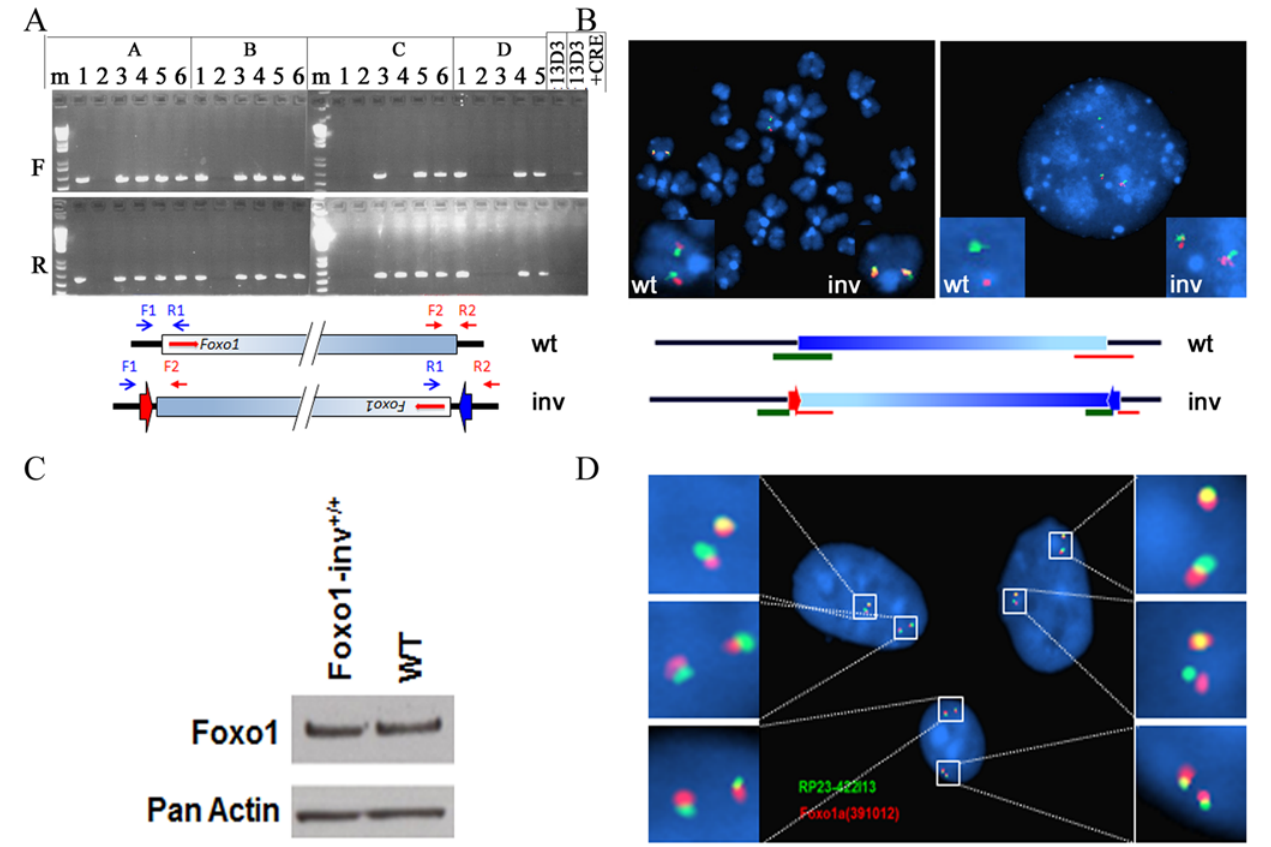
Figure 3. Analyses of inversion of the 4.9Mb syntenic region in double targeted ES cells. A. PCR analyses of CRE-transfected, FIAU selected ES cell clones. F, PCR amplification of the 4.9Mb borders using forward primers (RP24-F1 (blue arrow) and RP23-F2 (red arrow)); R, PCR amplification of the 4.9Mb borders using reverse primers (RP24-R1 (blue arrow) and RP23-R2 (red arrow)). Presence of PCR fragments in both the F and R PCR amplifications indicates the presence of the inverted 4.9M syntenic region. The scheme below the photograph shows the relative positions of the PCR primers on the wild type (wt) and inverted (inv) chromosomes, respectively. Arrowheads indicate the position of the remaining incompatible LoxP sites. Shaded blue box represents the 4.9Mb syntenic region, red arrows indicate the position and transcriptional orientation of Foxo1 . B. FISH analyses of metaphase and interphase chromosomes of one of the ES cell clones carrying the 4.9Mb inversion using the RP24 – 391O12 (green = centromeric border) and RP23 – 422I13 (red = telomeric border) BAC probes. The wild type chromosome 3 (wt) produced contiguous red and green hybridization signals, the chromosome 3 with the inversion (inv) shows split hybridization signals. Left — metaphase spread; right — interphase nucleus. Scheme below the micrographs shows the positions of the two BAC probes on the wild type (wt) and inverted (inv) chromosomes, respectively. C. Western blot of cell lysates from Foxo1-inv +/+ and wild type (WT) myoblasts probed with a Foxo1 antibody (Foxo1). Detection of actin serves as a loading control. D. Interphase nuclei of fibroblasts from a mouse homozygous for the 4.9 Mb syntenic region inversion (Foxo1-inv +/+ ) showing split signals after in situ hybridization with the RP23 – 422I13 (shown in green) and RP24 – 391O12 (shown in red) BAC probes.